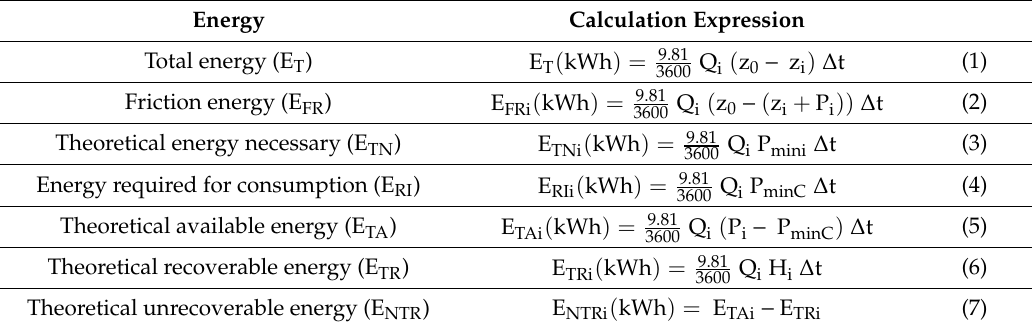
Table 3. Calculation expression for the di ff erent types of energy in a water distribution